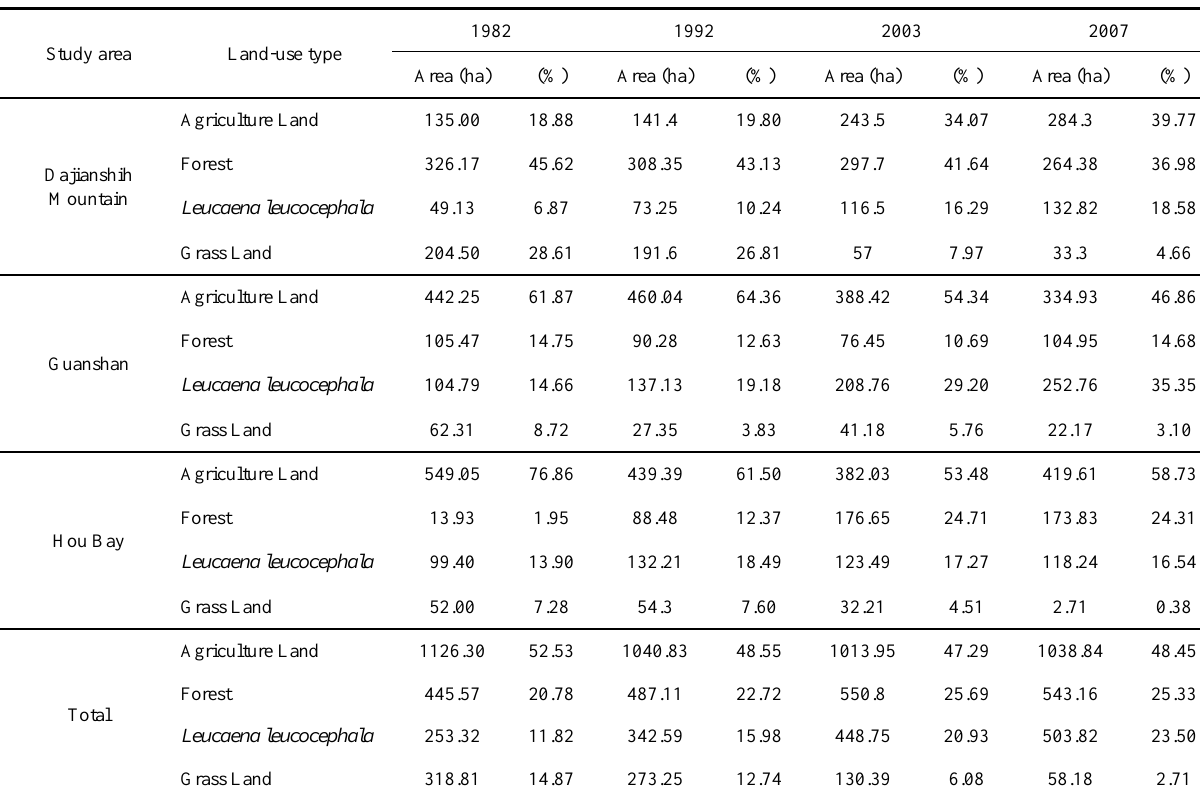
Table 4. Landuse change and Leucaena Leucocephala distribution from year 1982 to 2007.